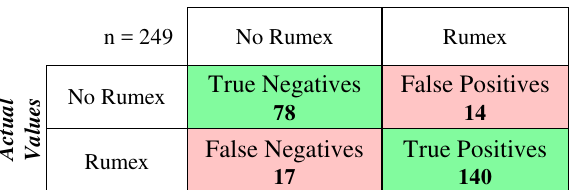
Figure 13. Confusion Matrix – Classification using the shifted trained